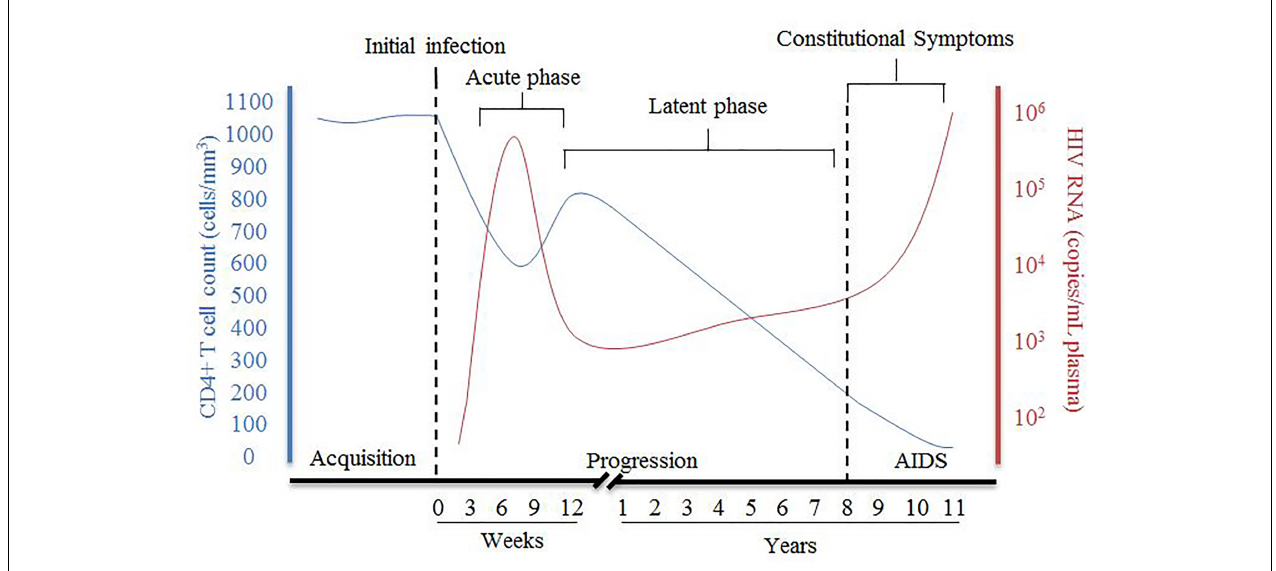
FIGURE 1 | Summary of pathogenesis of HIV infection in the presence of combined antiretroviral therapy. The disease progression of HIV in this figure is represented by the relative CD4+ T cell count in cells/mm 3 (blue) and HIV viral RNA in copies/mL plasma (red) and their relationship during HIV from acquisition to the development of AIDS [Figure was adapted from An and Winkler